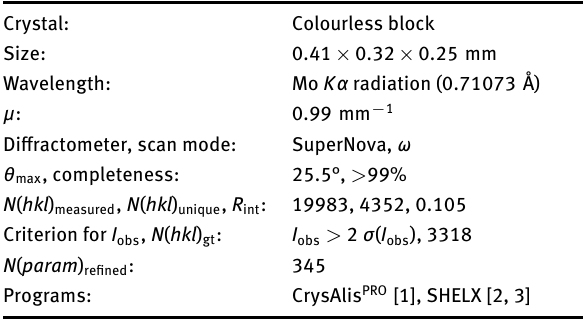
Table 1: Data collection and